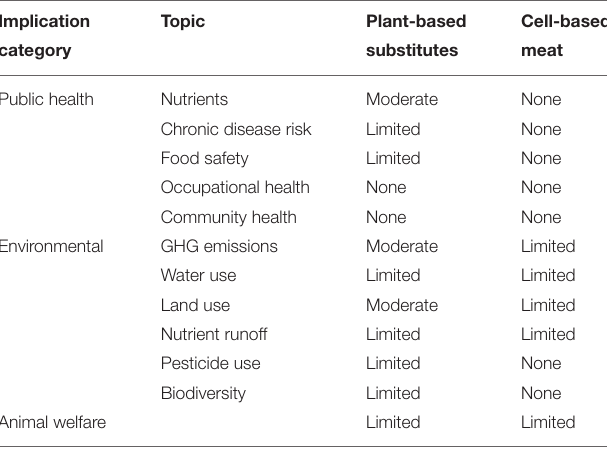
TABLE 1 | Level of characterization of public health, environmental, and animal welfare implications in research to date on meat alternatives.